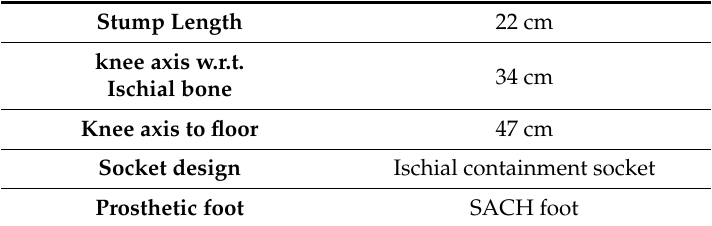
Table 3. Details of the amputation and